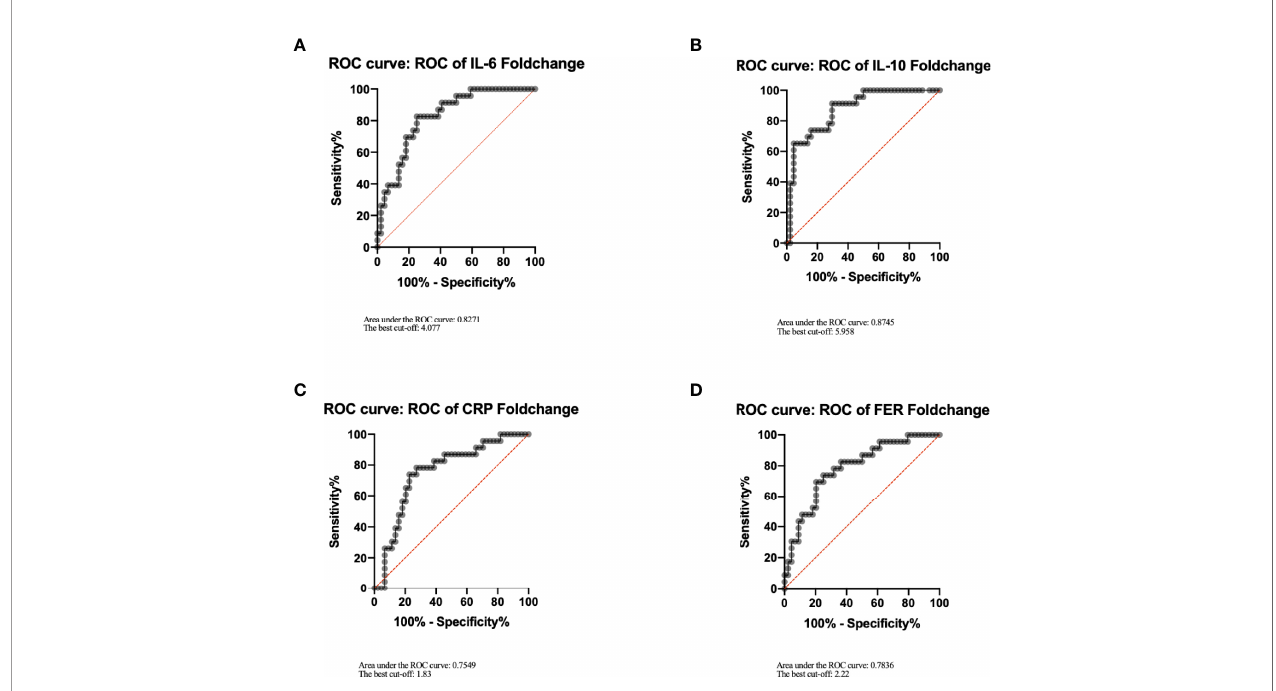
FIGURE 3 | Cutoffs of IL-6, IL-10, CRP, FER. IL-6 (A) , IL-10 (B) , CRP (C) , FER (D) were analyzed by ROC curve using GraphPad Prism, and the best cutoffs were determined according to the coordinates of the ROC curve. Youden index=sensitivity+speci fi city − 1. Its maximum value corresponds to the optimal